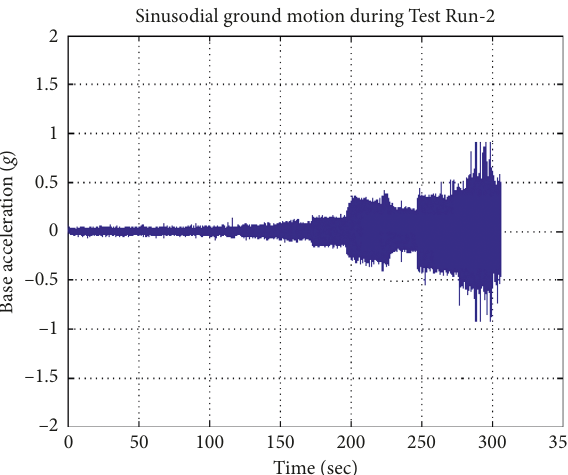
Figure 9: Acceleration recorded at the base during Test